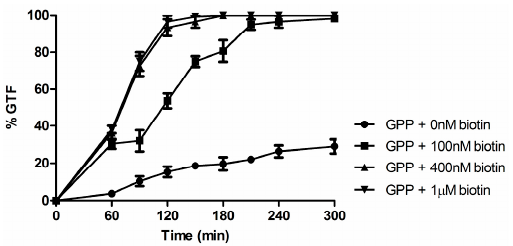
Figure 2. The germ tube formation (GTF) assays were conducted in glucose-phosphate-proline (GPP) (pH 6.5) containing variable levels of biotin at 37 ° C with rotary agitation at 220 rpm. Cultures were observed for 5 h, and plotted as , no addition; , 100 nM biotin; , 400 nM biotin; and ▼ , 1 µM biotin. Values shown are the average of triplicate experiments ± SD.